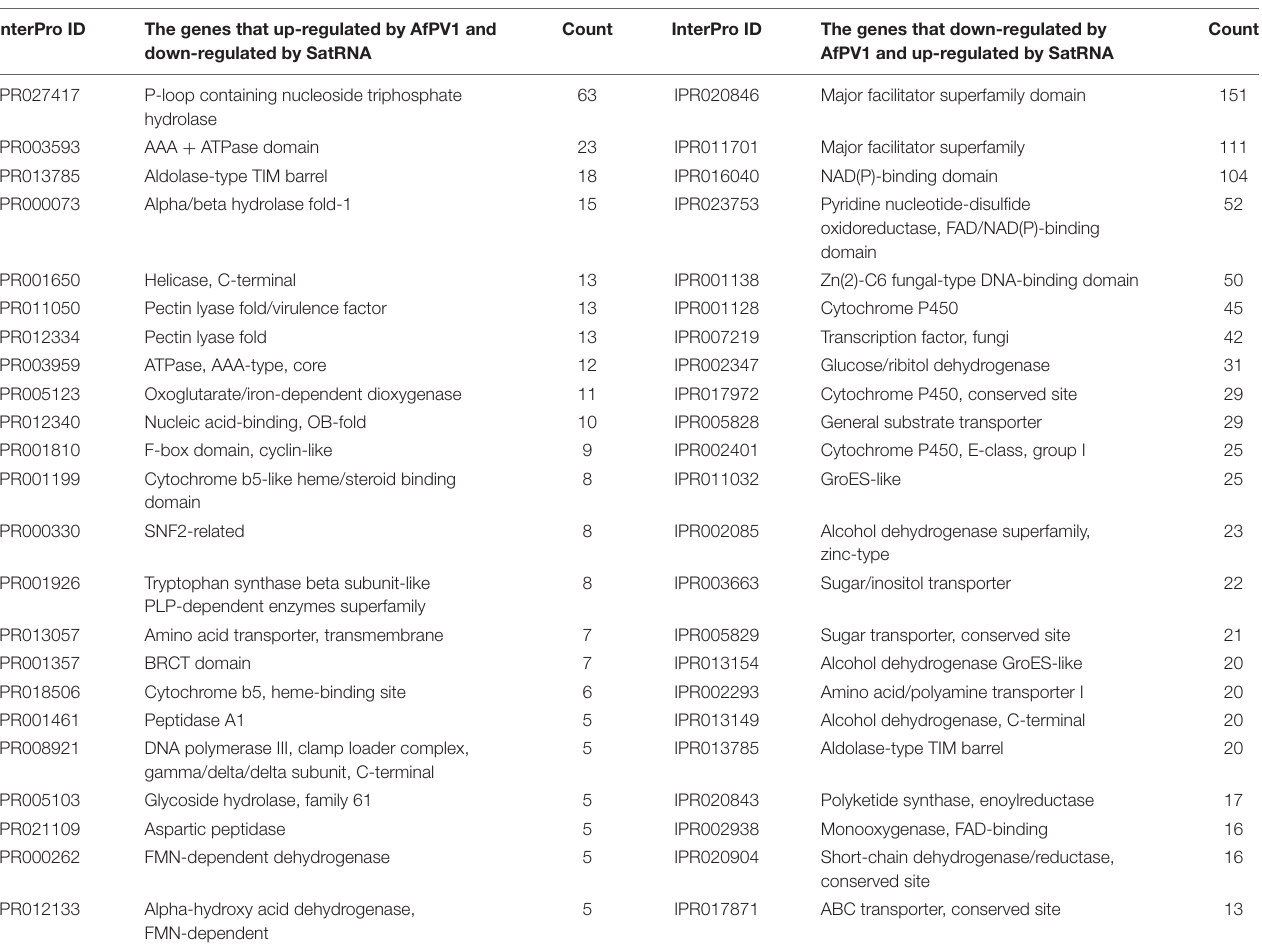
TABLE 1 | The most abundant InterPro domains according to the InterProScan. InterPro ID